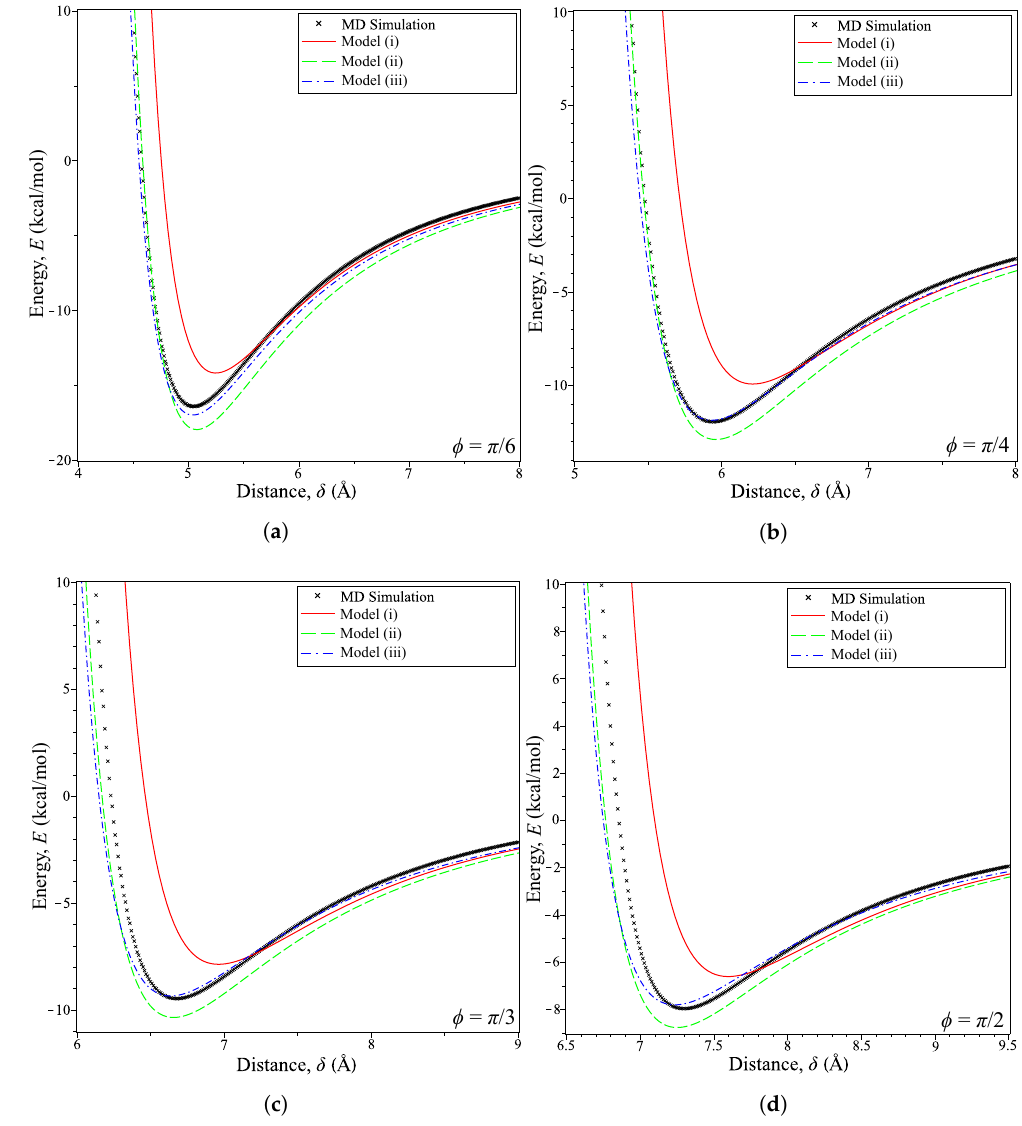
Figure 5. Energy profiles for coronene at fixed tilt angles: ( a ) φ = π / 6 ; ( b ) φ = π / 4 ; ( c ) φ = π / 3 ; and ( d ) φ = π / 2